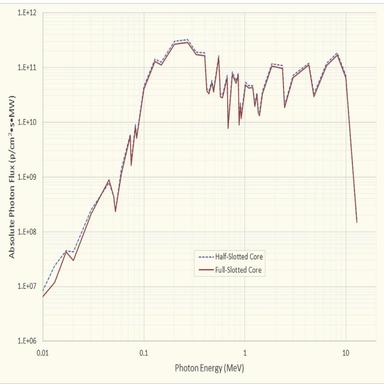
Comparison of Peak Photon Flux Spectral Distribution between Half- and Full-Slotted Cores (300 K).